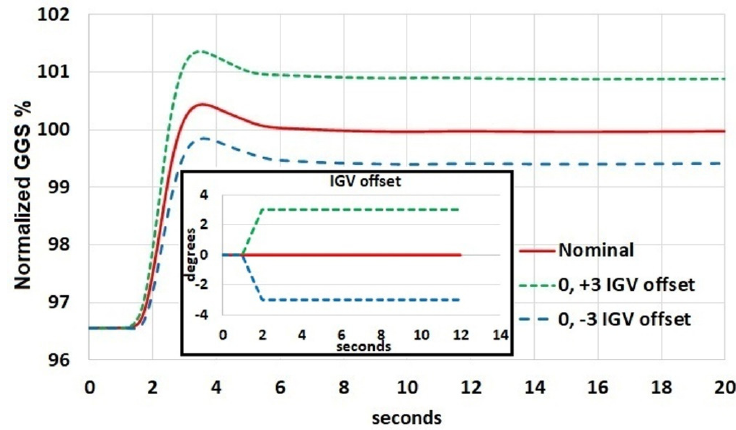
Figure 14. Simulated GGS response for 26–53% load and considering a positive and negative IGV offset of 3 degrees at 53% load.